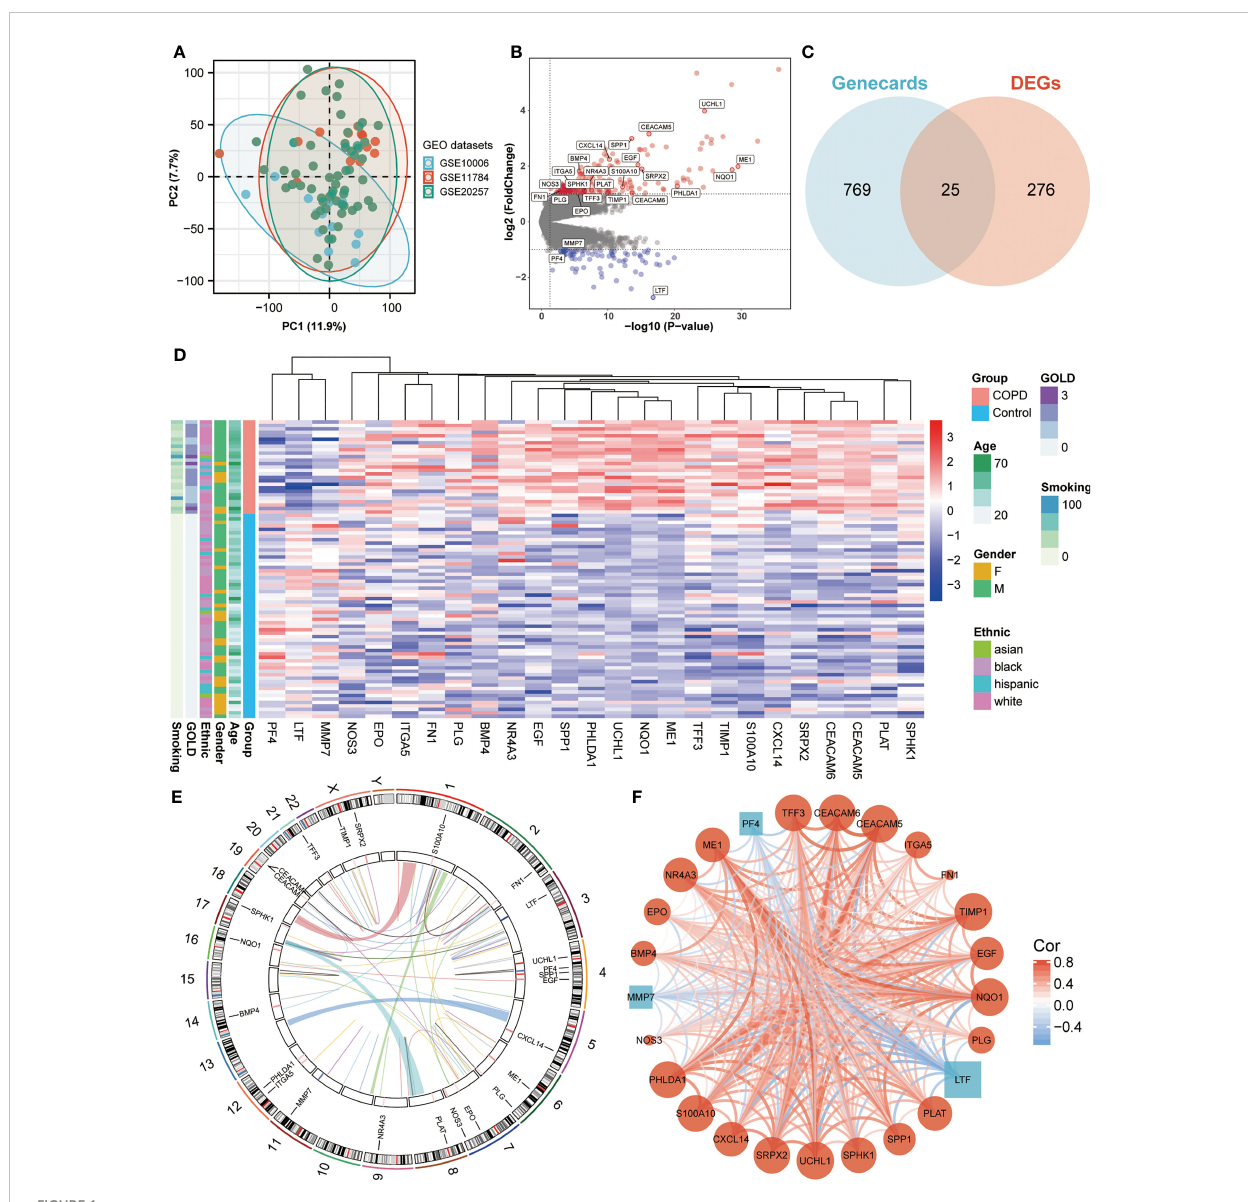
FIGURE 1 Expression of ANRGs in the SAE of COPD patients. (A) The PCA plot showed no signi fi cant separation among GSE10006 (blue), GSE11784 (red), and GSE20257 (green). (B) The volcano map showed DEGs between healthy non-smokers and COPD smokers. Red indicated upregulated genes, while blue indicated downregulated genes. Genes with no signi fi cant difference were marked in grey. (C) A Venn diagram showed the intersection between ANRGs acquired from the Genecards database (blue) and DEGs (red). (D) The relative expression of 25 differentially expressed ANRGs between healthy non-smokers and COPD smokers was shown in the heatmap. Red indicated high expression of ANRGs in COPD patients, while blue indicated low expression of ANRGs in COPD patients. (E) Chromosome regions of 25 differentially expressed ANRGs were shown in the outer circle of the circular heatmap, while the inner circle demonstrated the logarithmic fold changes. (F) Co-expression network of 25 ANRGs. Positive correlations were marked as red lines, while negative correlations were marked as blue lines. The strength of the correlation was indicated by the line thickness. Red circles represented upregulated ANRGs, while blue squares represented downregulated ANRGs. The degree of molecular interaction was represented in the size of the